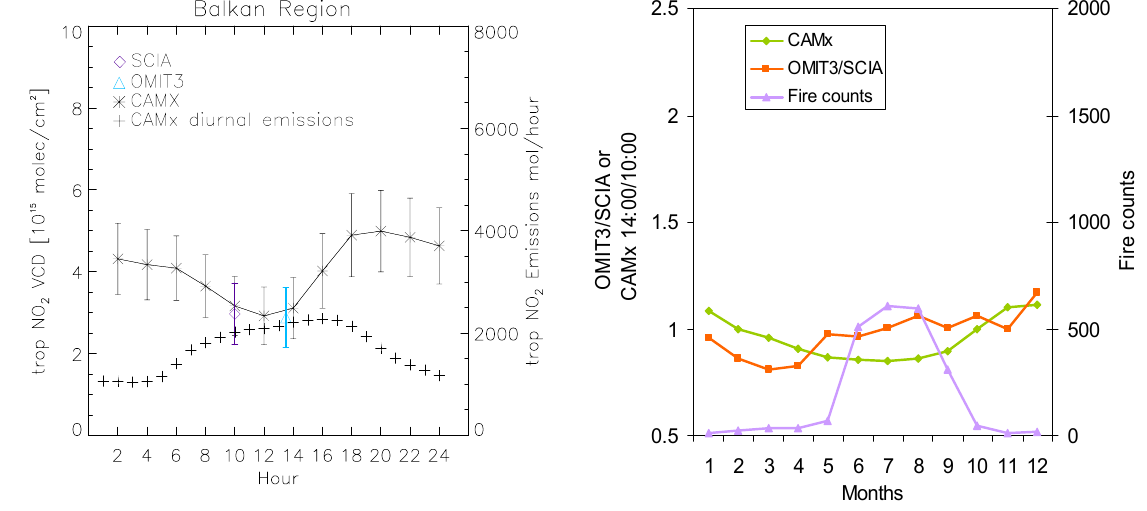
Fig. 4. Left panel: Average diurnal variation of tropospheric NO 2 columns modeled (from 1996 to 2001) by CAMx (asterisk symbols) and observed by SCIAMACHY (from 2004 to 2008) at 10:00LT (diamonds symbol) and OMI (from 2004 to 2008) at 13:30LT (triangle symbol) for the Balkan geolocations. The crosses indicate the average diurnal variation of CAMx NO 2 emissions over a 50 × 50km grid of the area under study. Right panel: Concurrent monthly average ratios of tropospheric NO 2 satellite measurements (OMIT3 over SCIAMACHY), model simulations (CAMx 14:00/10:00) over urban areas and the total monthly fire counts over the Balkan geolocations for the time period 2004-2008.